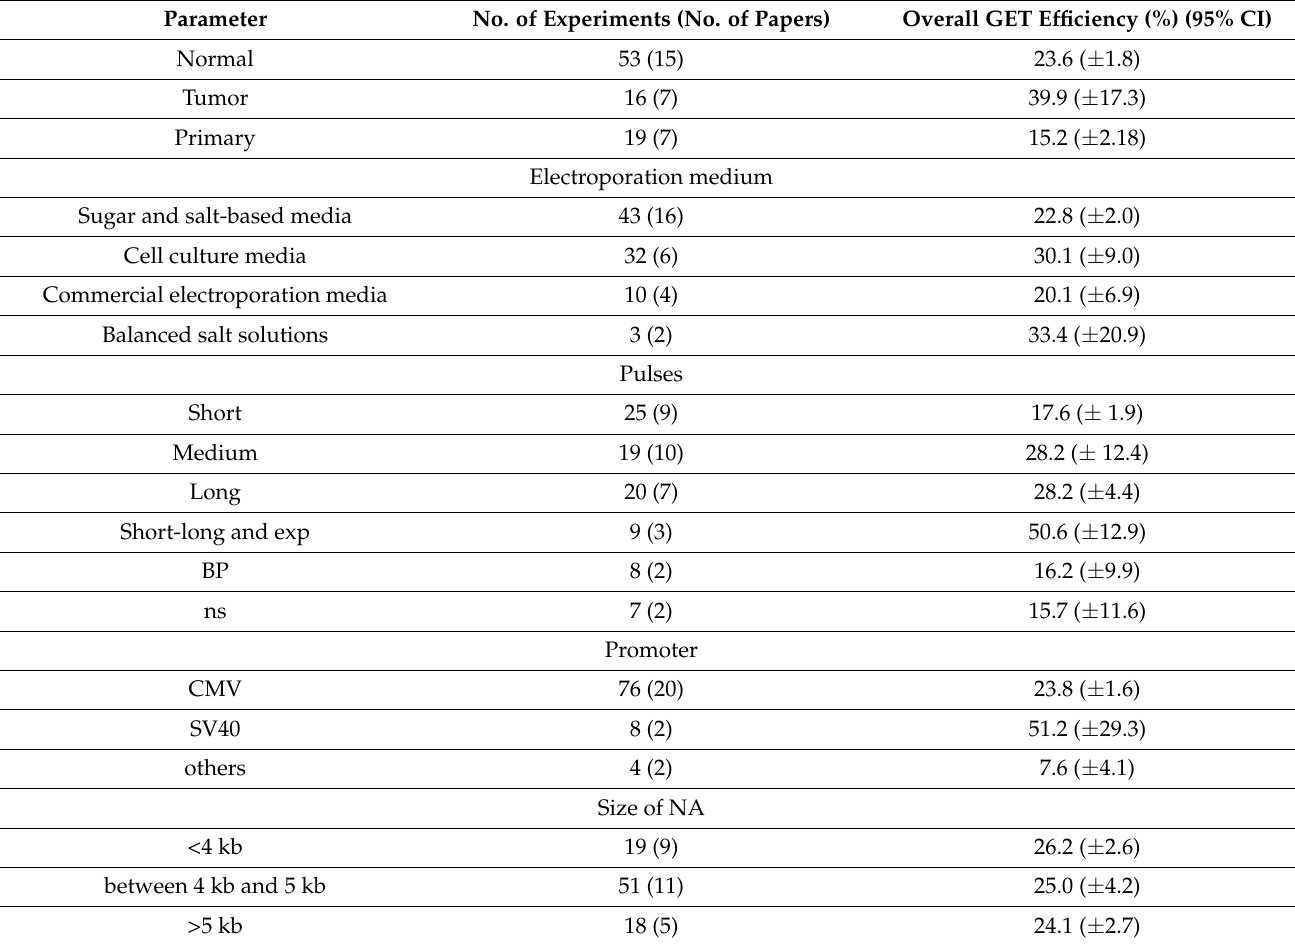
Table 3. Results of the subgroup analysis. According to the results of the I 2 test, there was a high degree of heterogeneity in all subgroups (I 2 >